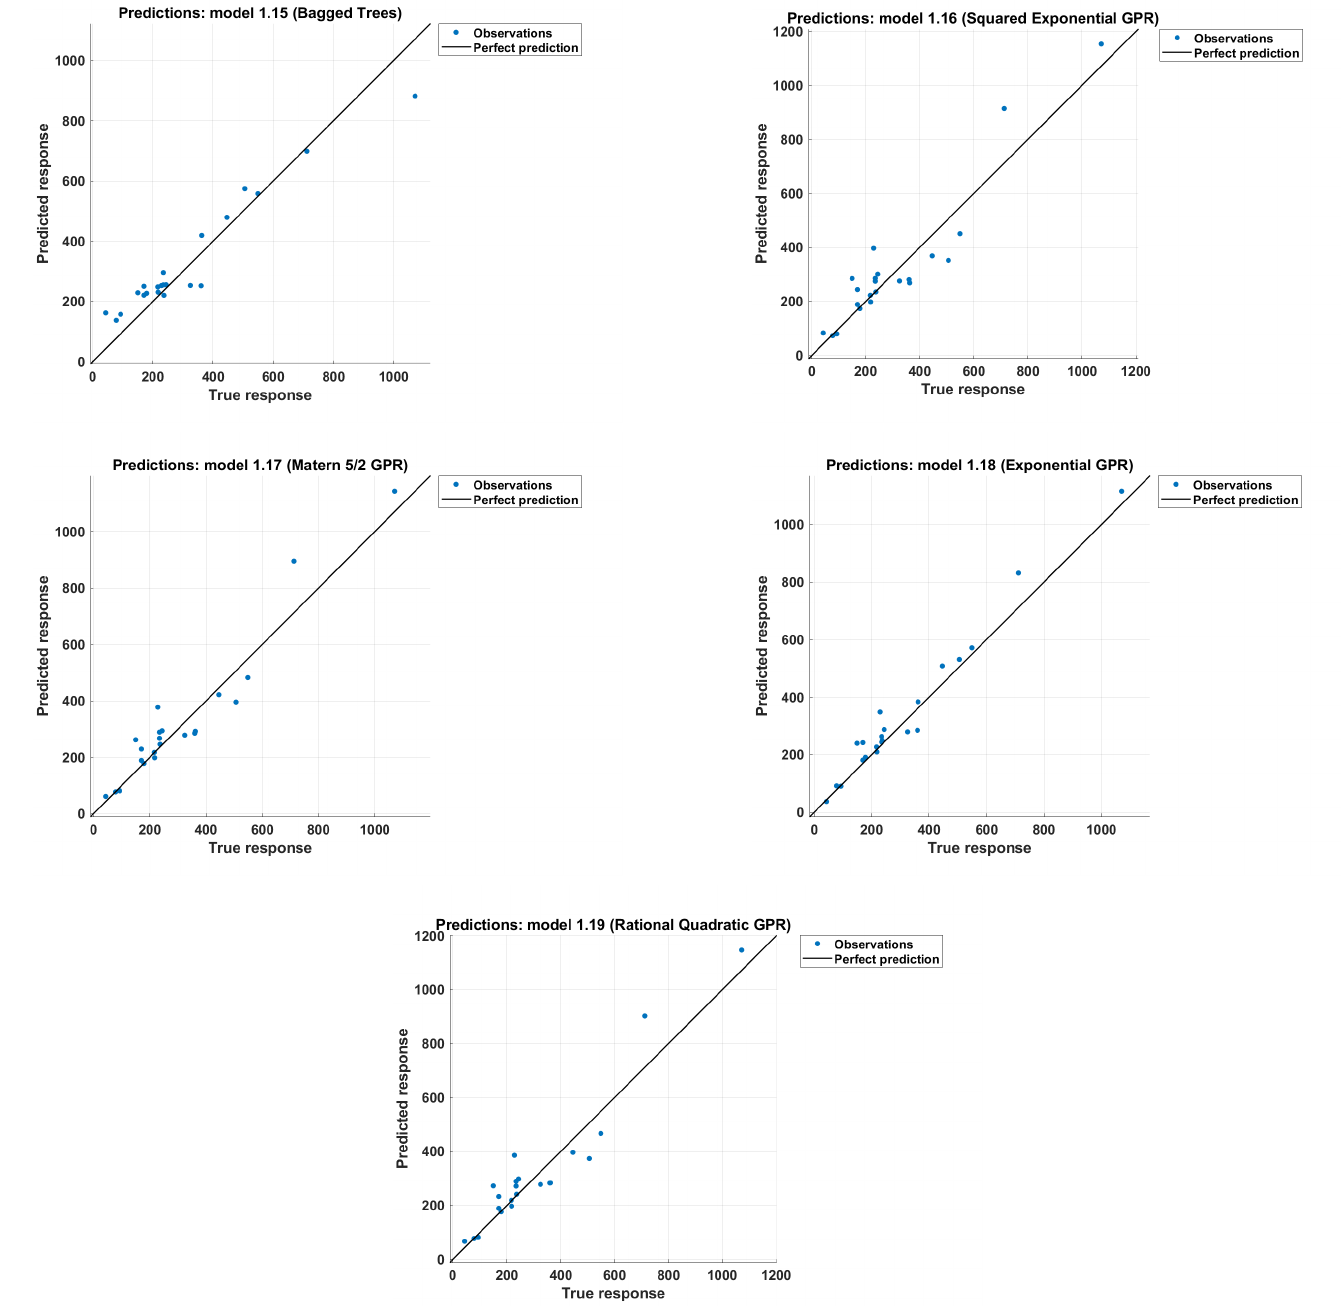
Figure 2. SF calculated using various models versus the record